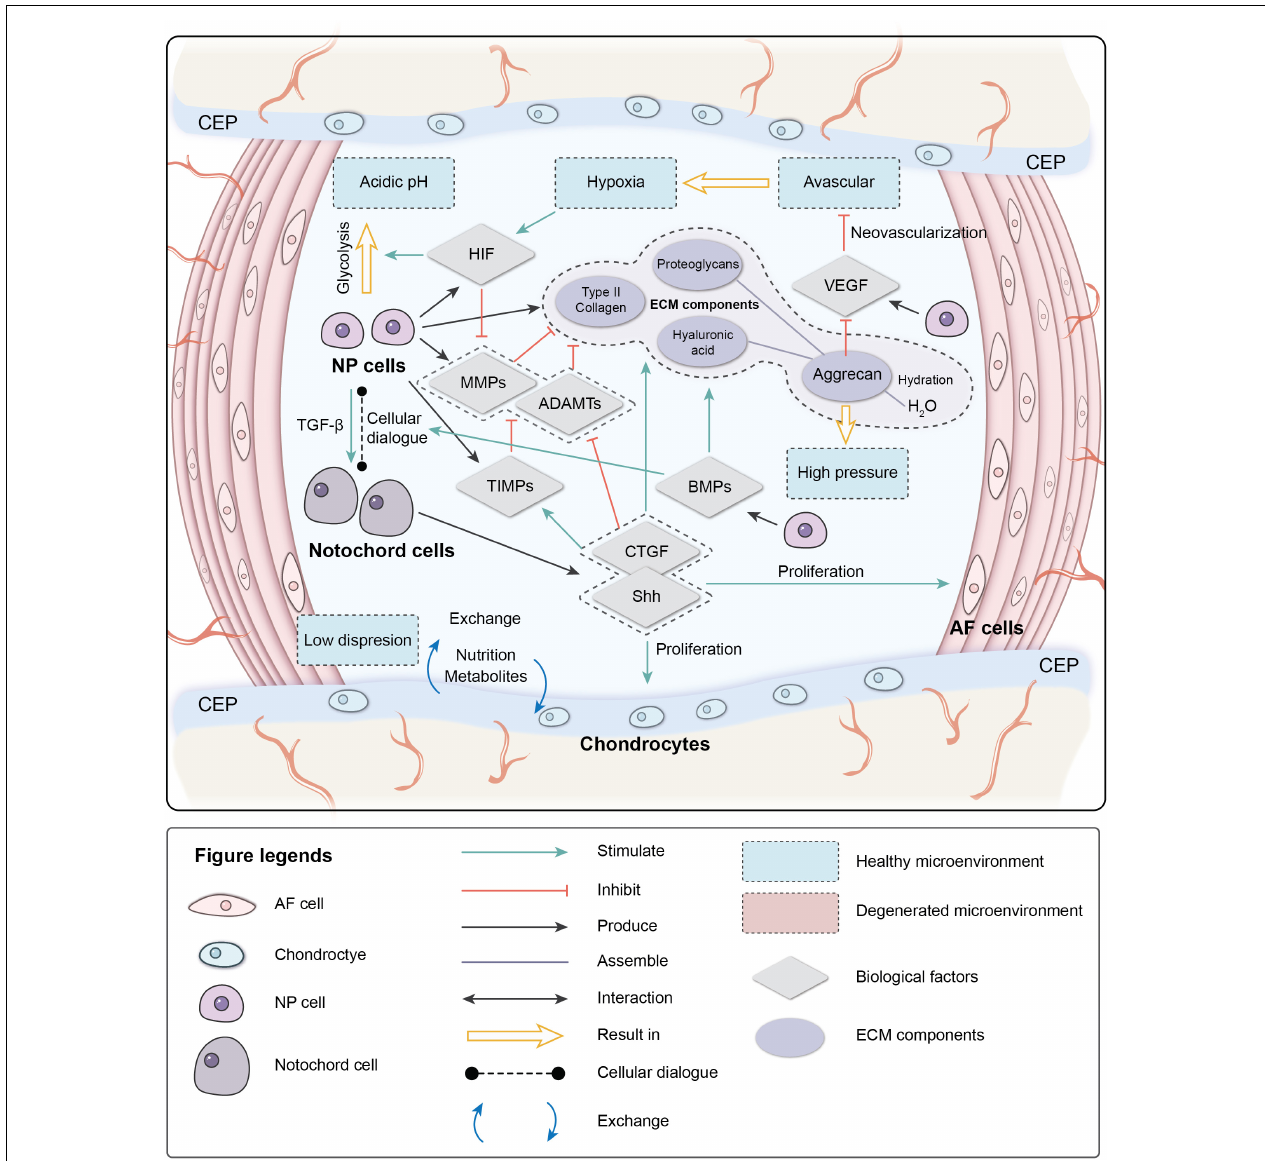
FIGURE 1 | Physiological microenvironment of intervertebral disk (IVD). AF, annulus fibrosus; NP, nucleus pulposus; CEP, cartilage endplate; ECM, extracellular matrix; HIF, hypoxia-inducible factor; MMPs, metalloproteinases; ADAMTs, metalloproteinase with thrombospondin motifs; TIMPs, tissue inhibitors of metalloproteinases; CTGF, connective tissue growth factor; Shh, sonic hedgehog; BMPs, bone morphogenetic protein; VEGF, vascular endothelial growth